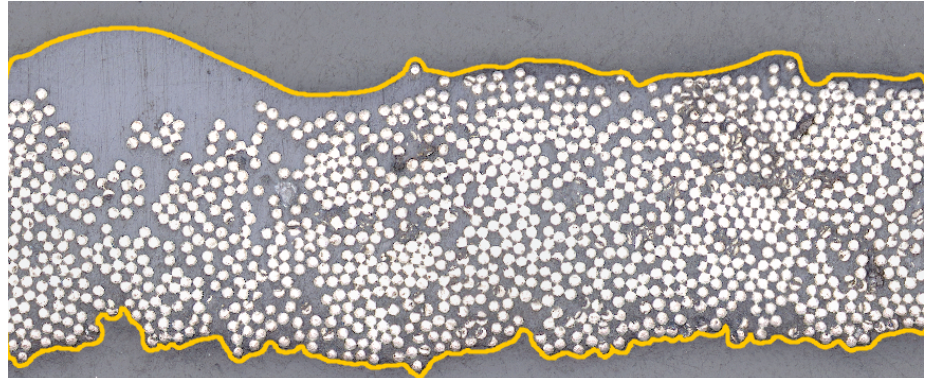
Figure 7. Example of tape boundary polygon construction.